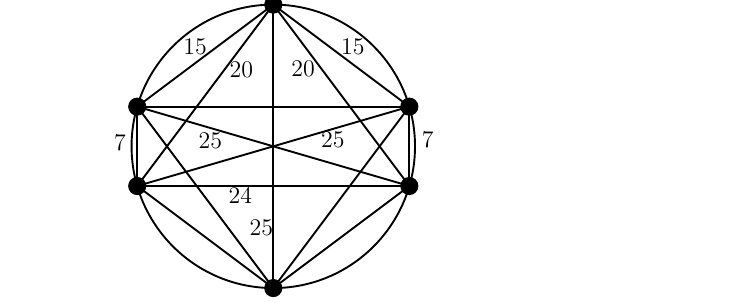
Figure 3: Pairwise integral distances for opposite pairs of points with diameter 25.